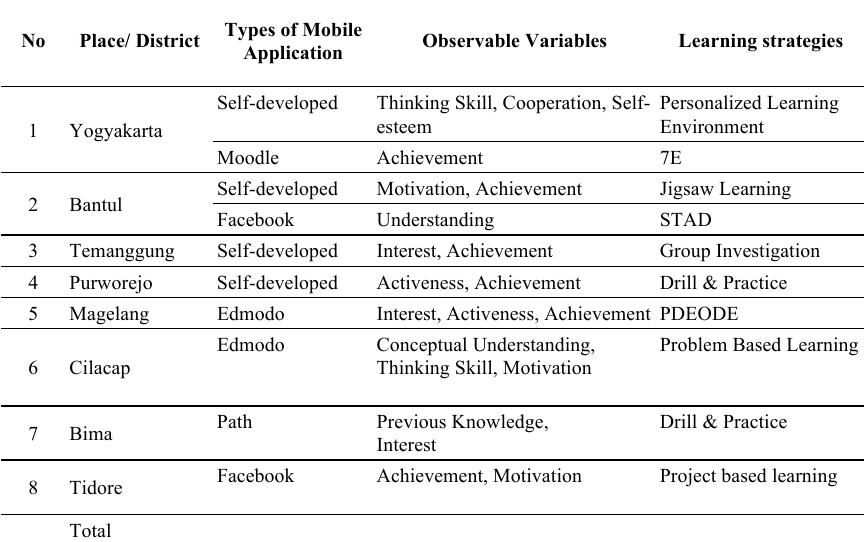
Table 2. Observed